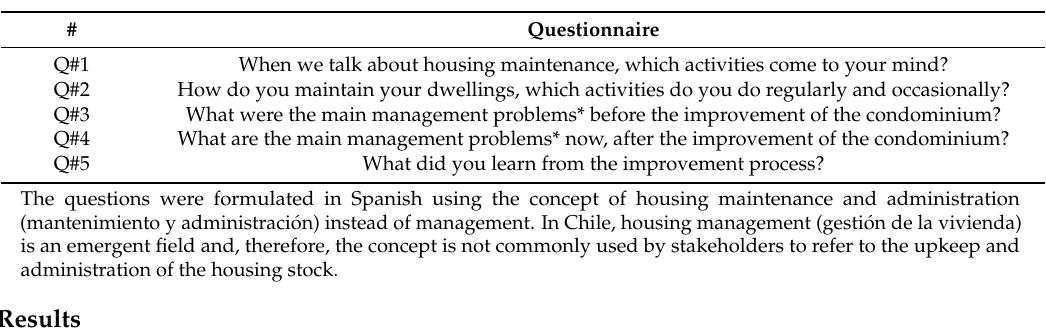
Table 4. Questionnaire group interview with condominium